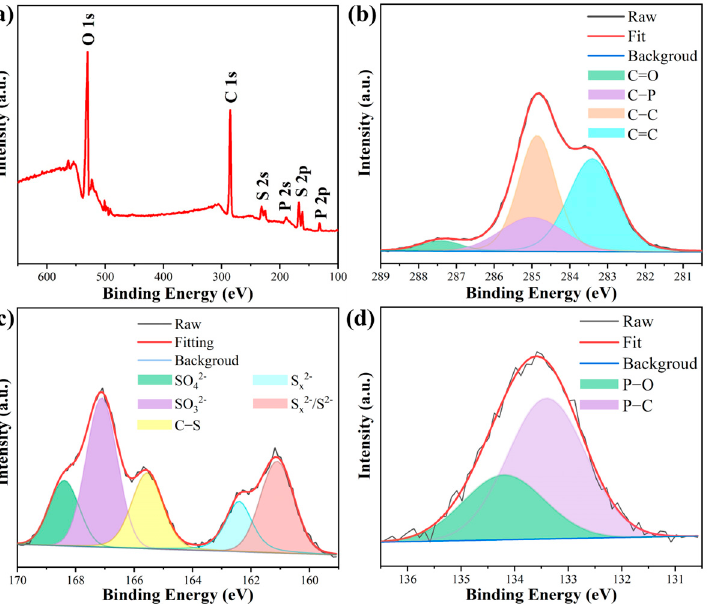
Figure 4. ( a ) XPS survey of P-SQDs. The corresponding high-resolution XPS spectra for ( b ) C 1s, ( c ) S 2p and ( d ) P 2p.